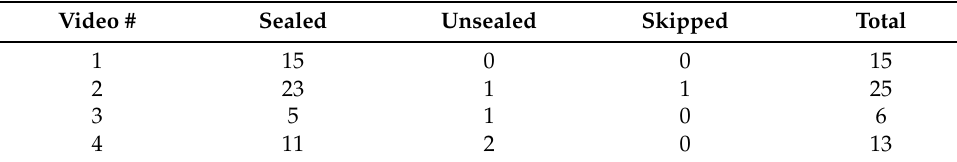
Table 1. General information about the videos